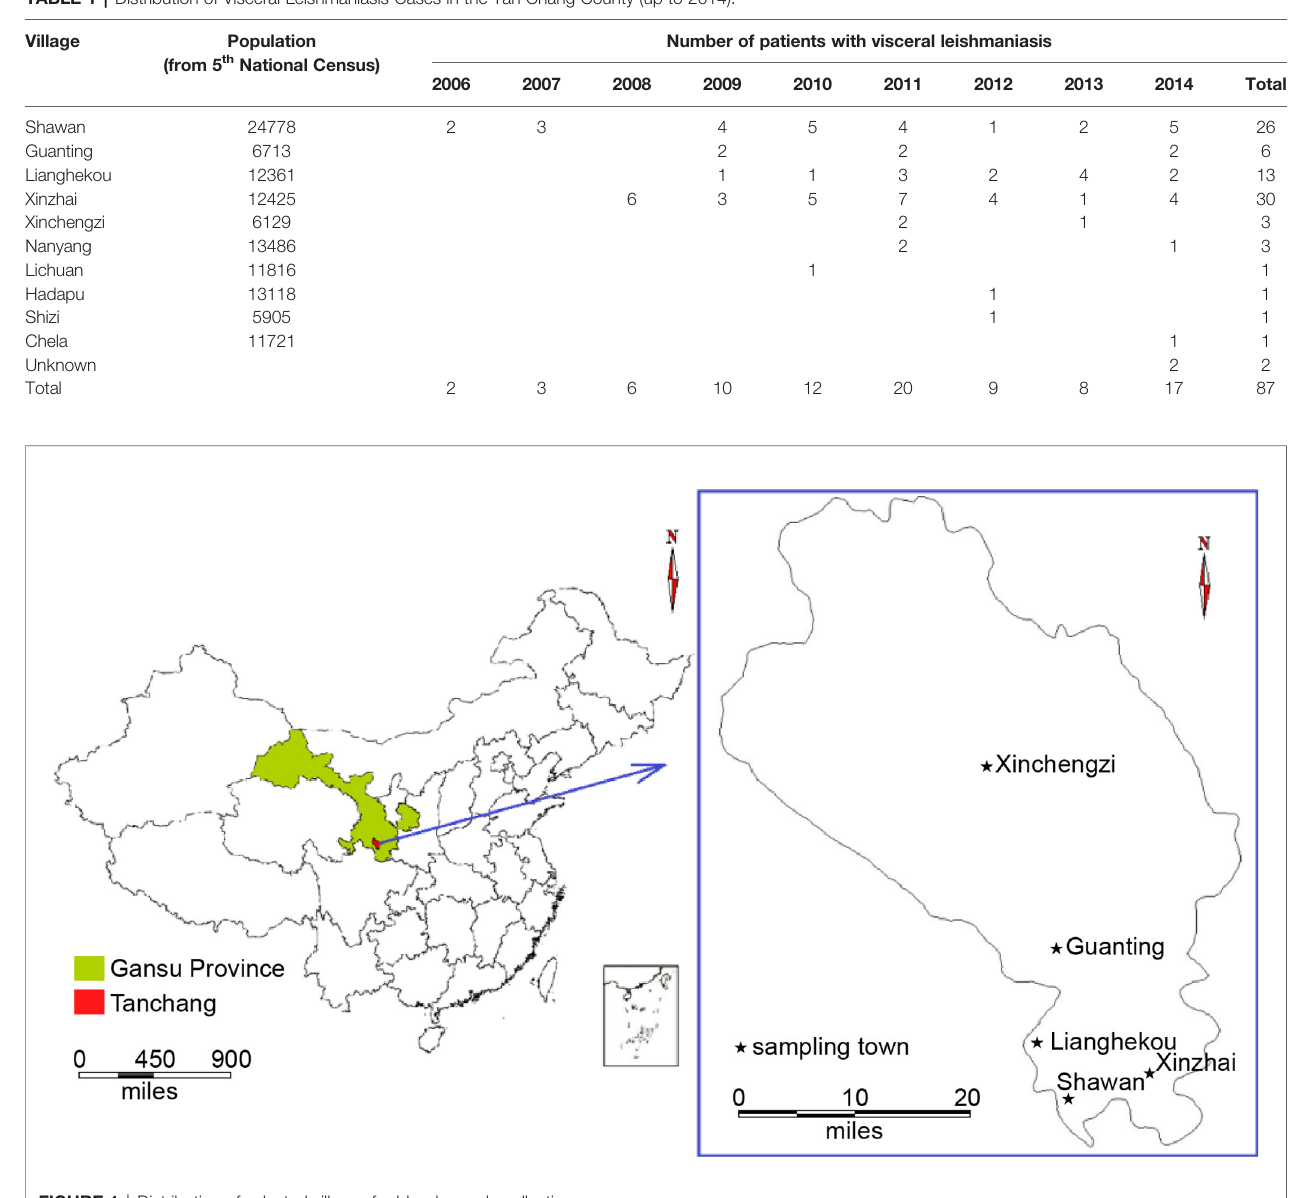
FIGURE 1 | Distribution of selected villages for blood sample collection.